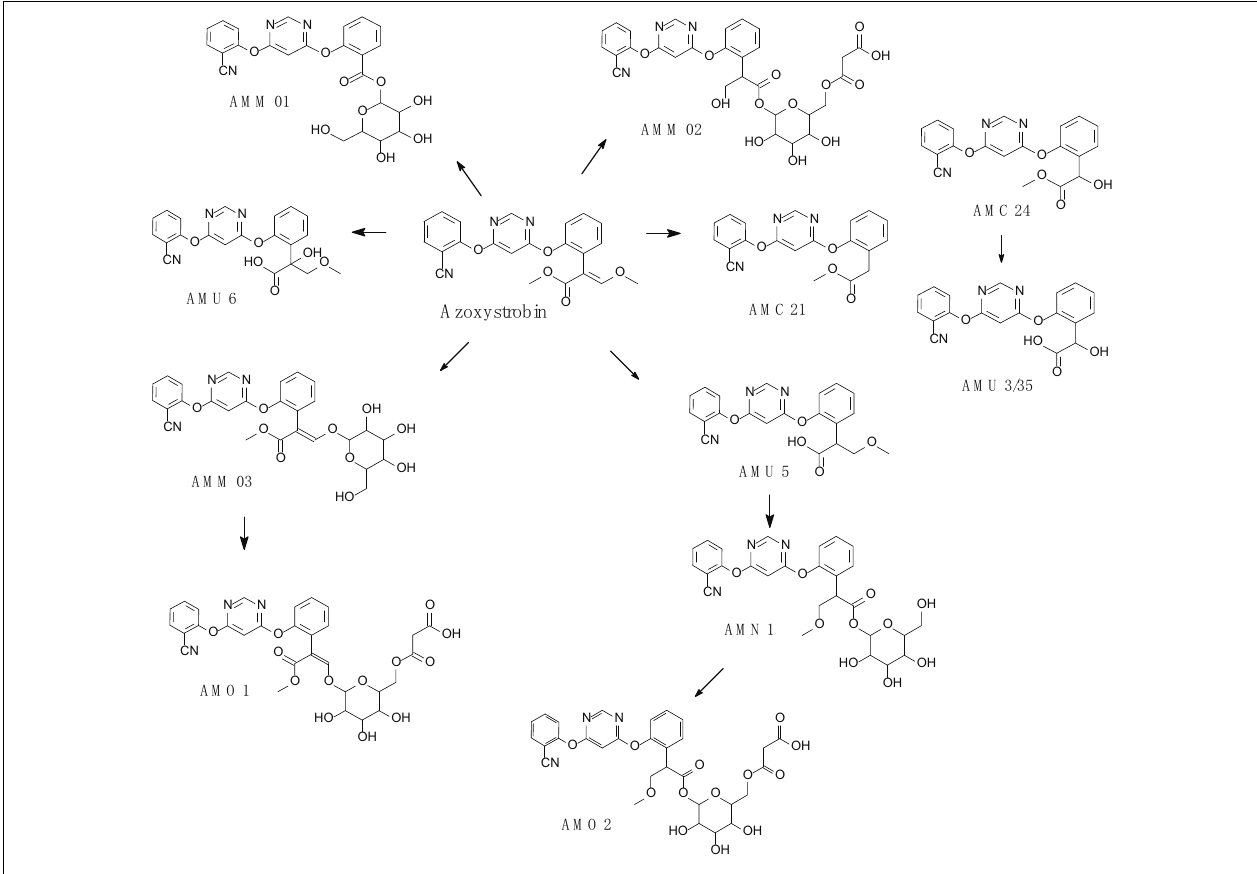
photoisomerization ( E → Z ), acrylate double bond cleavage, photohydrolysis of nitrile group and methyl ester, and phenol and oxidative cleavage of acrylate double bonds after the cleavage of aromatic rings. The results also showed that azoxystrobin absorbs light at higher wavelengths (290 nm) in aqueous environments, which facilitate its photodegradation. Singh et al. (2010) explored the metabolism of (14) C-azoxstrobin under aqueous conditions at pH 4, 7, and 9 and identified metabolite R234886 as (E)-2-{2-[6-(2-cyano-phenoxy) pyrimidin-4-yloxy] phenyl}-3-methoxyacrylic acid, which is the main metabolite of azoxystrobin. Compared to acidic (pH 4) or neutral (pH 7) conditions, metabolite formation occurred in larger quantities and comparatively faster under alkaline (pH 9) conditions. Chastain et al. (2013) found that the photochemical reactivity of azoxystrobin was enhanced as the solvent polarity decreased. This phenomenon indicates that the accumulation of azoxystrobin tends to occur inside the cuticle, where it is photodegraded, or at the surface of crop leaves. Azoxystrobin metabolism is similar to the degradation of methoxyiminoacetate (Balba, 2007) and the fate of trifloxystrobin in plants and kresoxim-methyl in soils, plants, and rats.